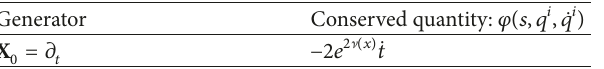
Table 46: Noether symmetry and the corresponding conserved